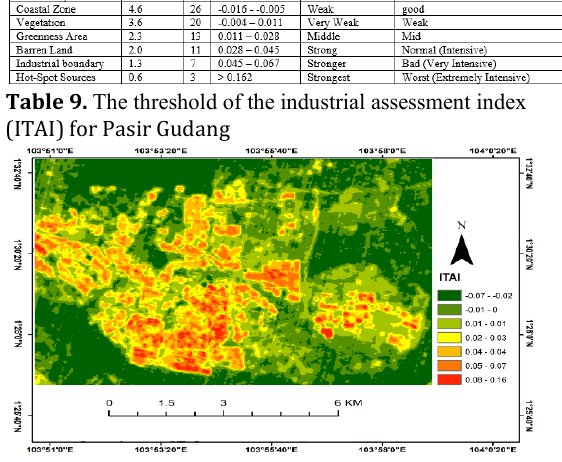
Figure 8. The ITAI classification map of industrial evaluation in Pasir Gudang